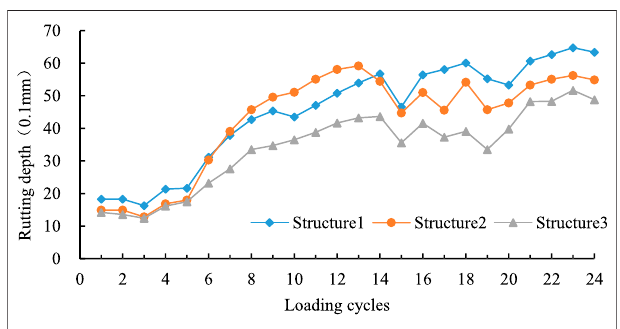
FIGURE 10 | The relation curve of rutting depth with loading period.